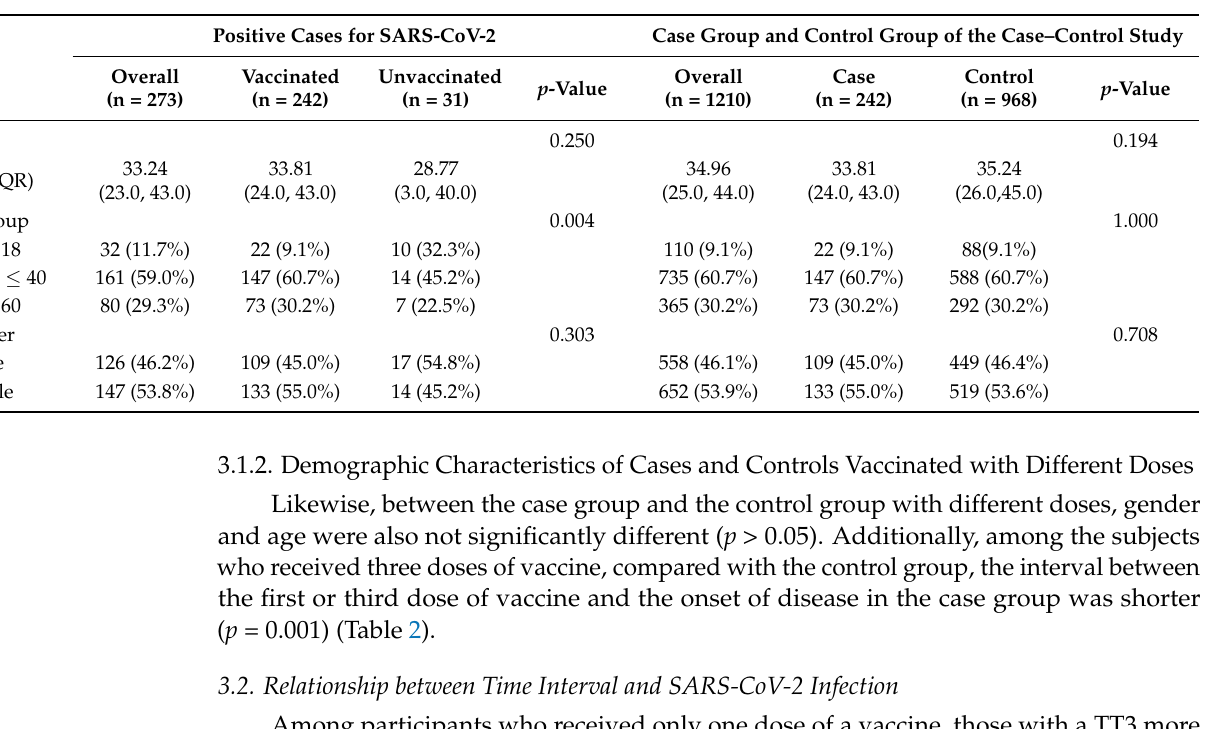
Table 1. Demographic characteristics of the 273 retested positive cases for SARS-CoV-2 and the final included cases and